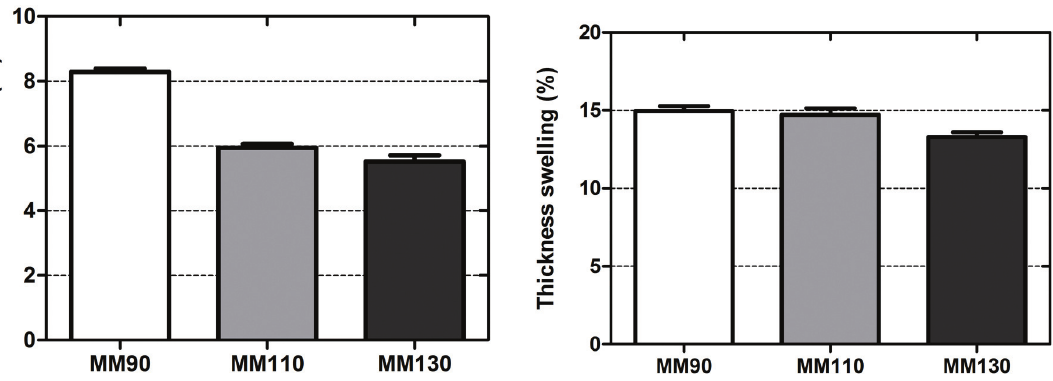
Figure 2. Variation in average moisture content of Tauari particleboards.